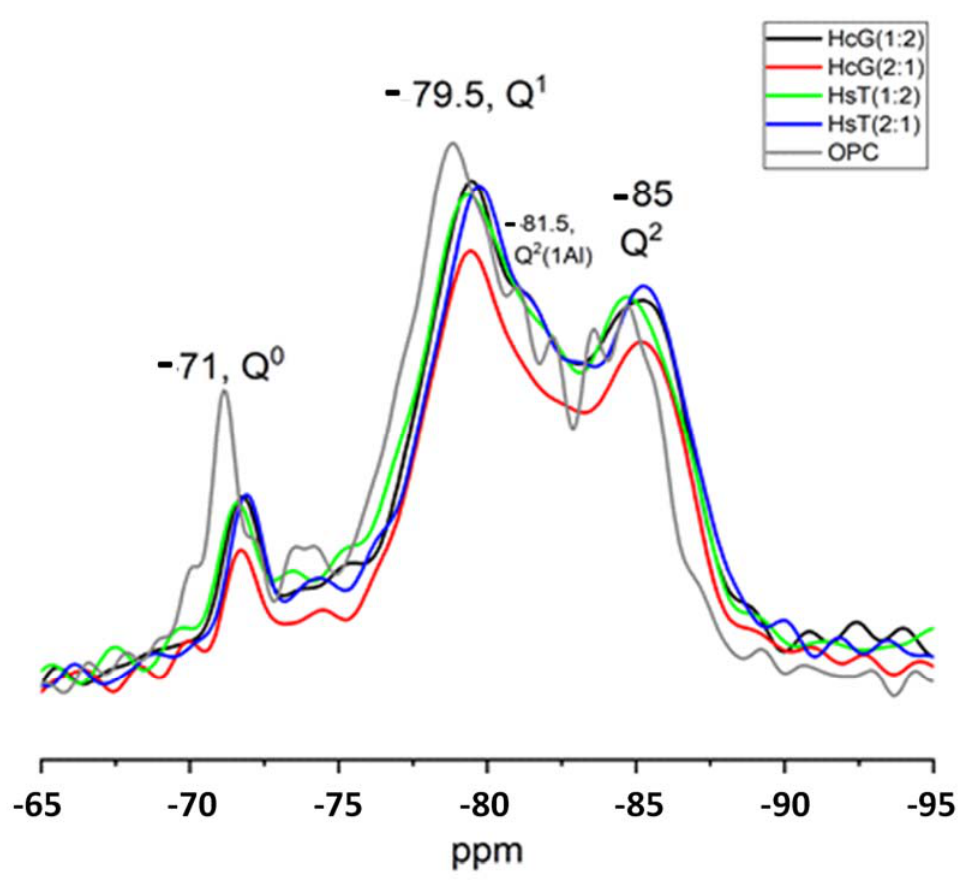
Figure 5. 29 Si NMR spectra for 90-day 7% HsT/glass and HcG/glass pastes.